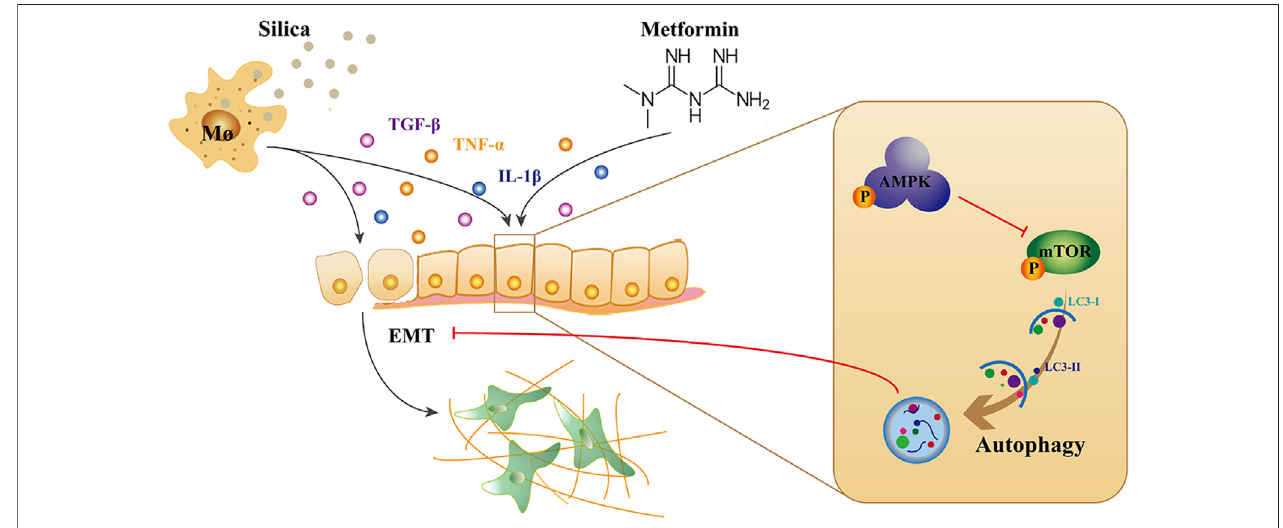
FIGURE 9 | The mechanism of action of metformin against silica-induced pulmonary fi brosis. Uptake of silica by alveolar macrophages release high level of in fl ammatory cytokines, and induced EMT which epithelial cells gradually lose their epithelial characteristics and acquire the mesenchymal phenotype. Metformin can activate AMPK and inhibit mTOR, leading to autophagy induction, thereby reducing the EMT process in silicosis.